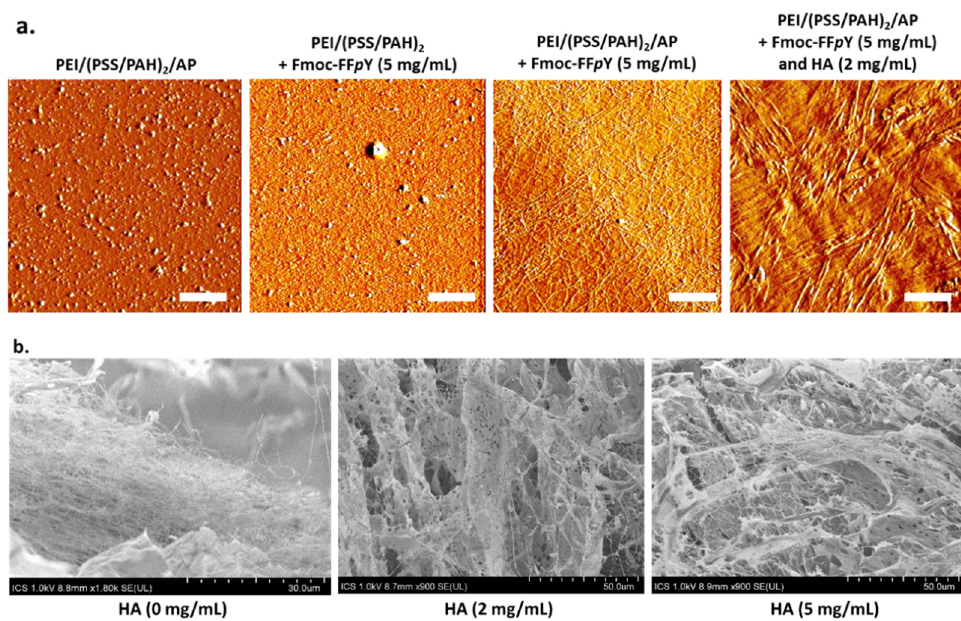
Figure 5. ( a ) AFM images (deflection mode, dry state) of the multilayer film PEI/(PSS/PAH) 2 in the following conditions (from left to right): after the adsorption of AP on the top of the film, when the multilayer is brought in contact with Fmoc-FF p Y solution (5 mg/mL), after the buildup of the peptide self-assembled architecture from a precursor peptide solution [Fmoc-FF p Y] = 5 mg/mL in absence or in presence of HA (2 mg/mL). Scale bar = 2 µ m; ( b ) SEM images of supramolecular hydrogels formed from PEI/(PSS/PAH) 2 /AP in presence of Fmoc-FFpY (5 mg/mL) and HA at 0, 2 and 5 mg/mL.